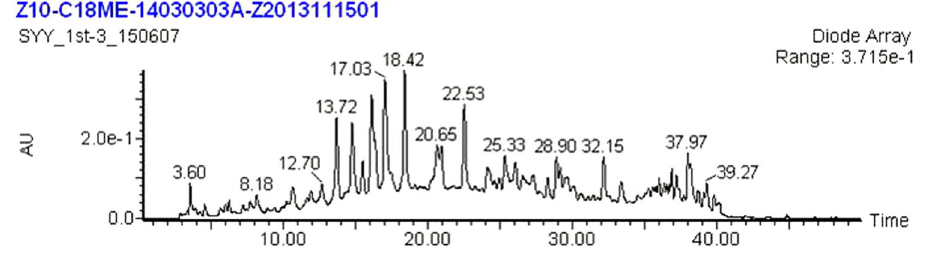
Figure 4. PN first fractionation